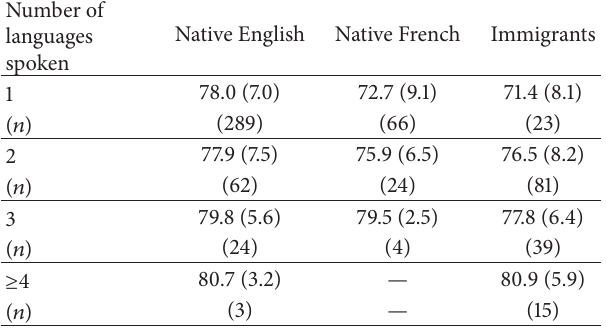
Table 2: Age of diagnosis of Alzheimer’s disease. Number